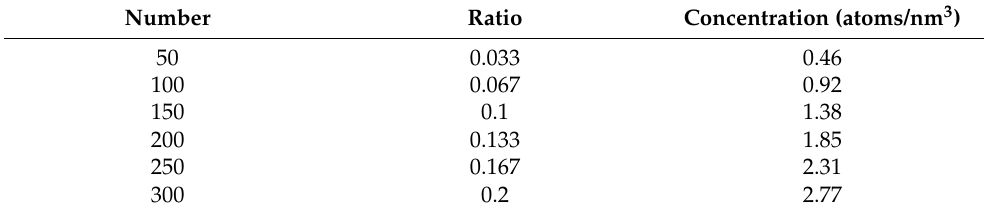
Table 2. The lithium-ion ratio corresponds to the lithium-ion concentration. Number